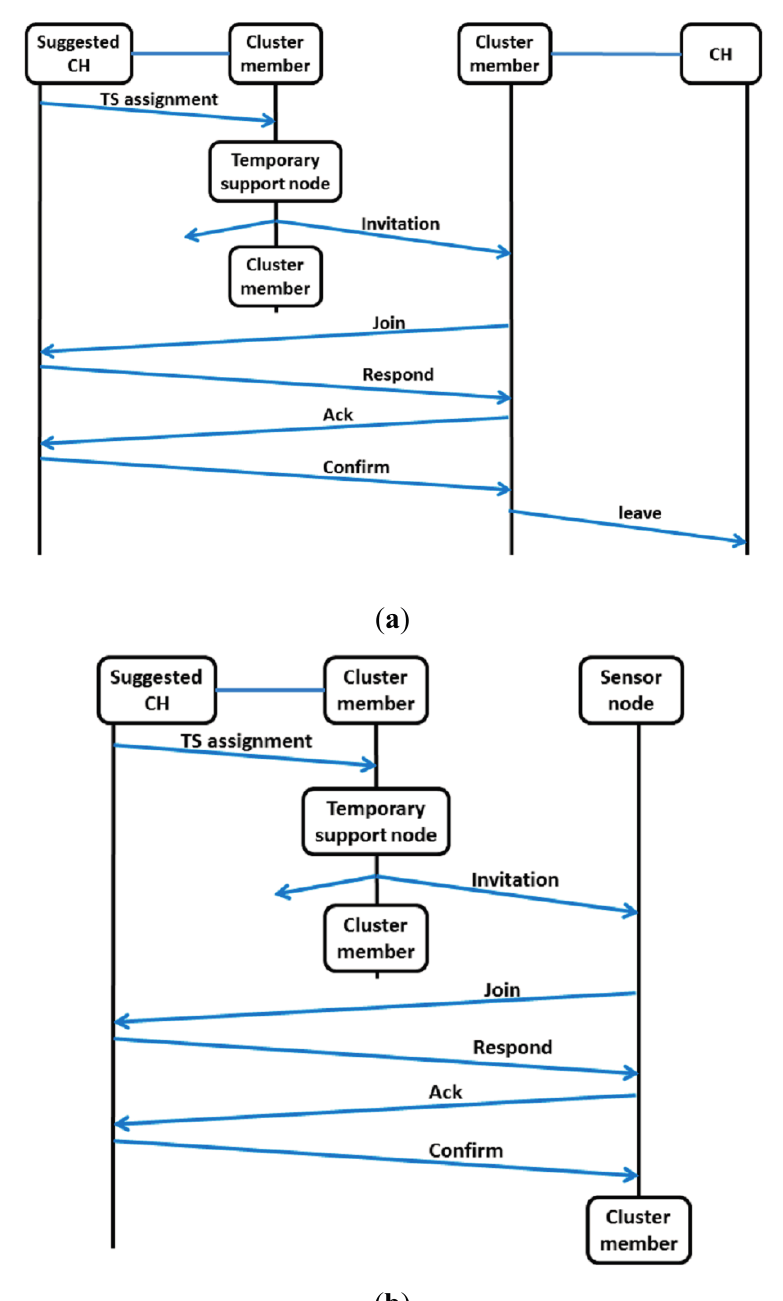
Figure 6. Packet exchanges during sub-phase 2 when the receivers of the invitation packets are ( a ) active cluster members and ( b ) sensor